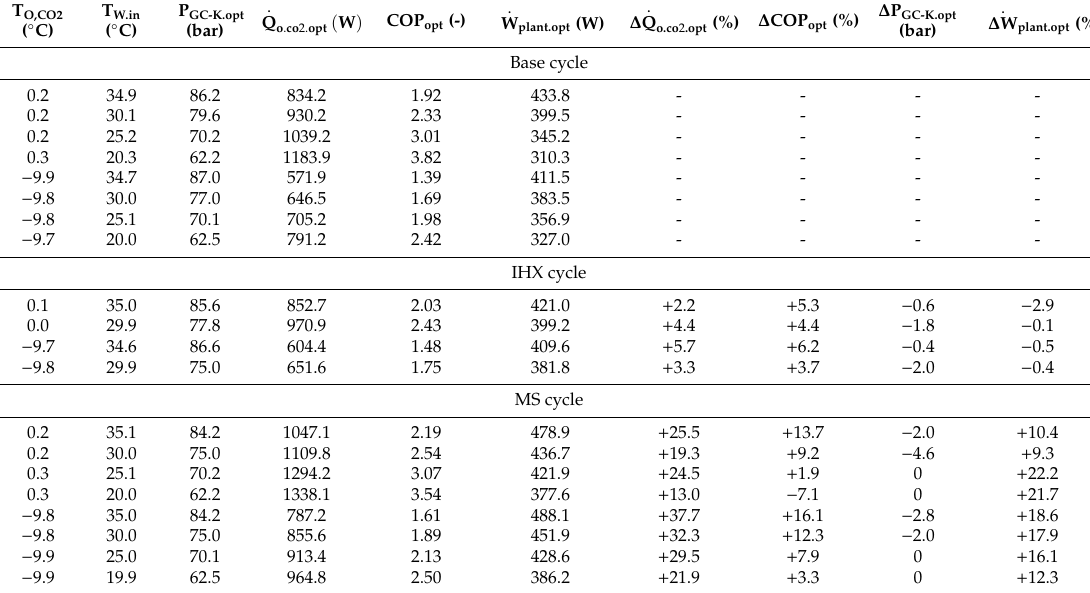
Table 4. Adjusted results at optimal operating